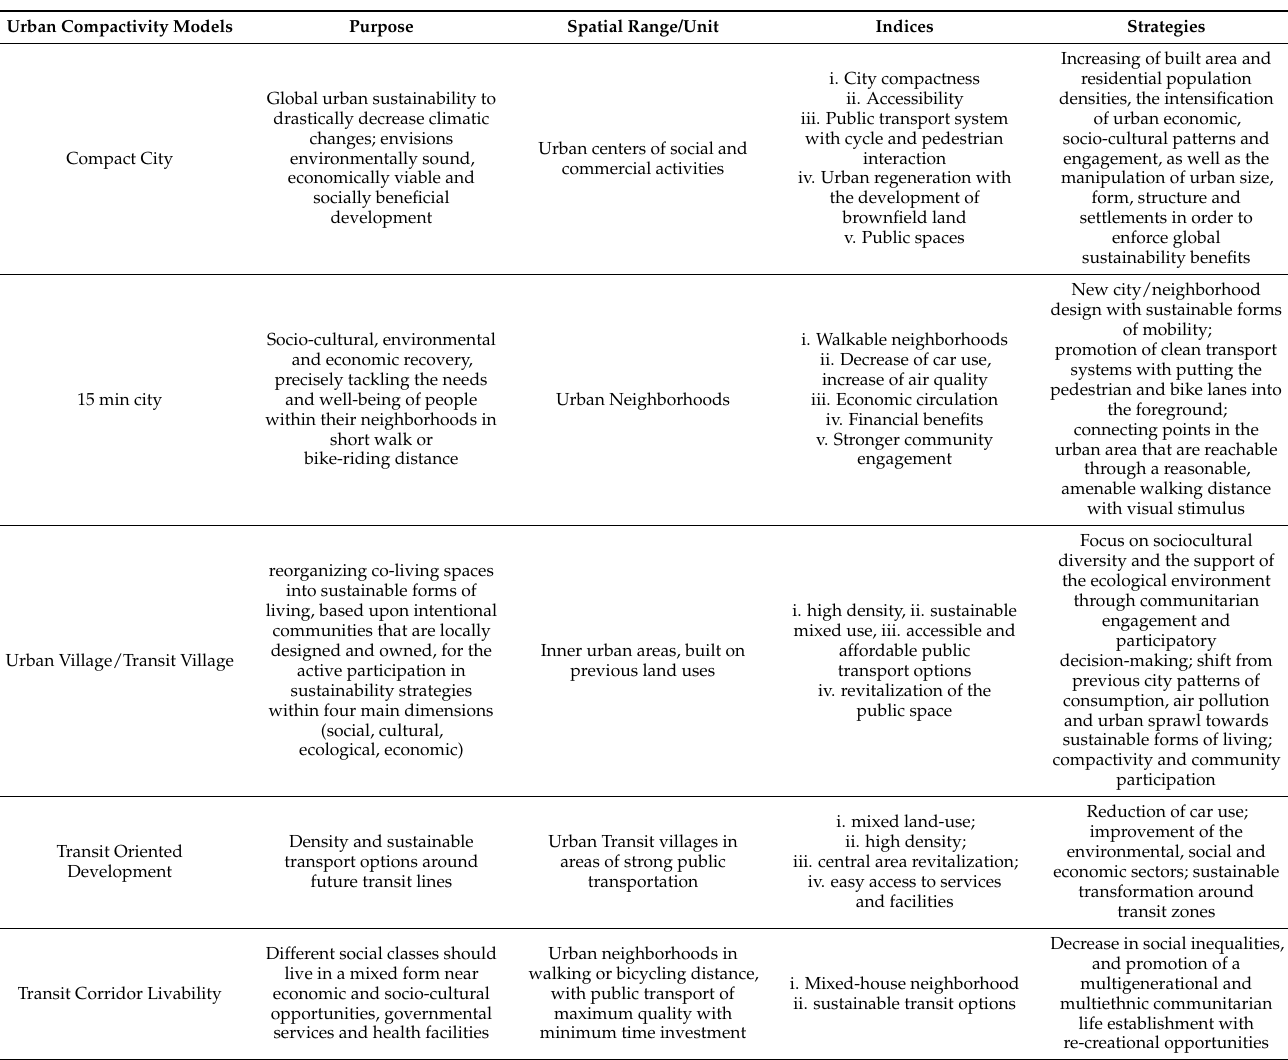
Table 2. Urban Compactivity Model